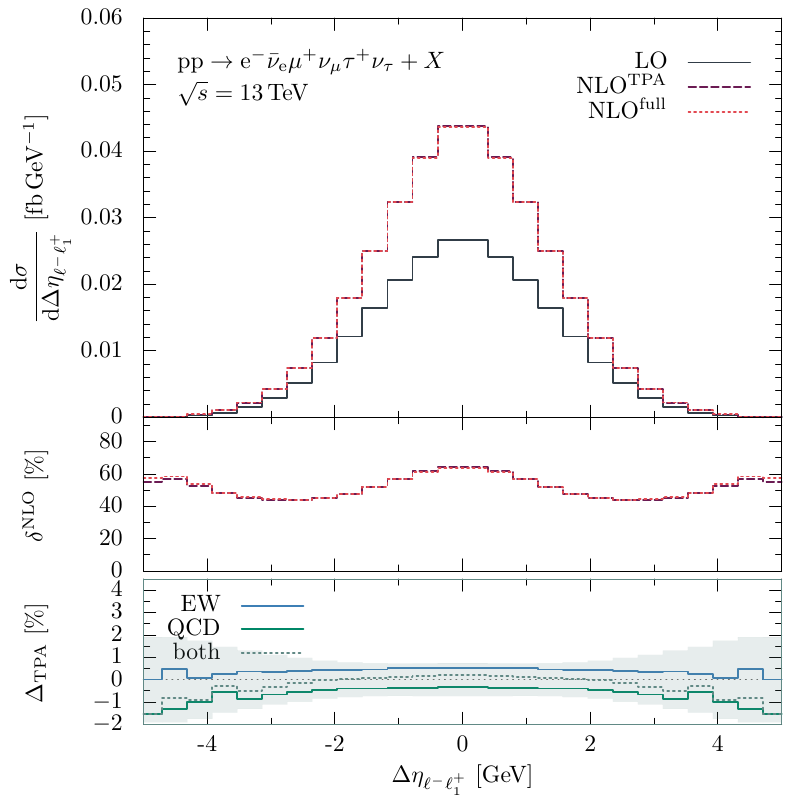
Figure 13. As in (cid:12)gure 12, but for the di(cid:11)erential distributions in the pseudorapidity di(cid:11)erence (cid:1) (cid:17) of the negatively-charged lepton ‘ (cid:0) and the leading positively-charged lepton ‘ + ‘ (cid:0) ‘ + 1 o(cid:11) shell, the EW virtual contributions have a signi(cid:12)cant impact on the EW corrections